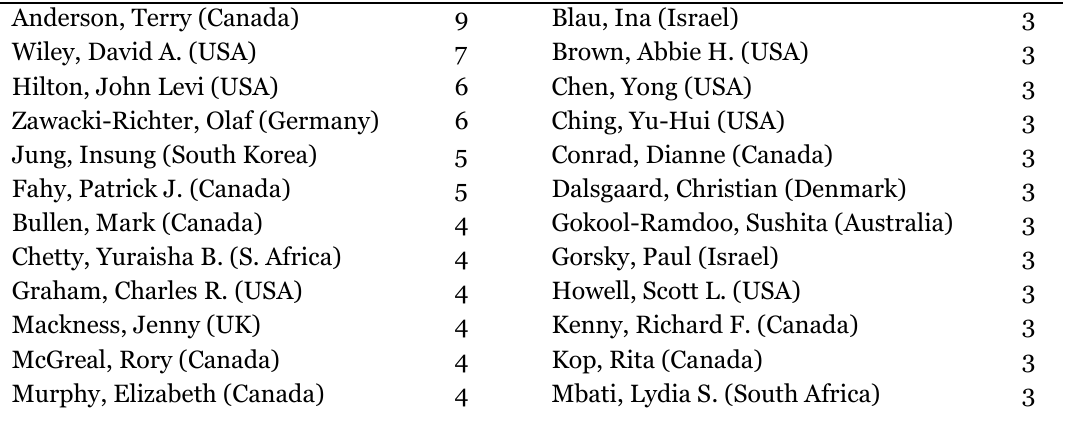
Leading Contributors and Number of Their Published Articles Anderson, Terry